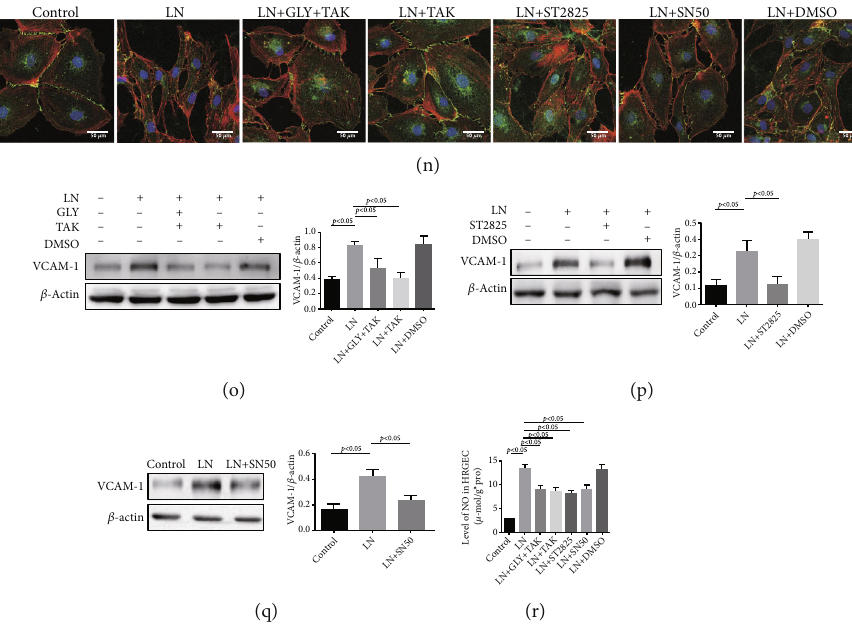
Figure 6: Inhibition of the TLR4/MyD88/NF- κ B/p65 pathway relieved GEC injury in HMGB1-induced LN. (a) Western blotting showed the expression of TLR4, NF- κ B/p65, p-I κ B α , and MyD88 in HRGECs cultured with LN plasma. (b) IF staining for NF- κ B/p65 (red) in HRGECs cultured with LN plasma. (c, e, g, and h) Western blotting of TLR4, MyD88, and p-I κ B α in LN plasma-stimulated HRGECs pretreated with di ff erent inhibitors. (d, f, and i) IF staining of NF- κ B/p65 (red) in LN plasma-stimulated HRGECs pretreated with di ff erent inhibitors. (j, k) TEER and permeation in LN plasma-stimulated HRGECs pretreated with di ff erent inhibitors ( n = 6 , p < 0 : 05 ). (l) The level of SDC-1 in supernatant of LN plasma-stimulated HRGECs pretreated with di ff erent inhibitors measured by ELISA. (m) IF staining of SDC-1 in LN plasma-stimulated HRGECs pretreated with di ff erent inhibitors. (n) IF staining of VE-cadherin (green) and F- actin (red) in LN plasma-stimulated HRGECs pretreated with di ff erent inhibitors. (o – q) Western blotting of VCAM-1 in LN plasma- stimulated HRGECs pretreated with di ff erent inhibitors. (r) The level of NO in LN plasma-stimulated HRGECs pretreated with di ff erent inhibitors. ∗ p < 0 : 05 vs. control group; # p < 0 : 05 vs. LN